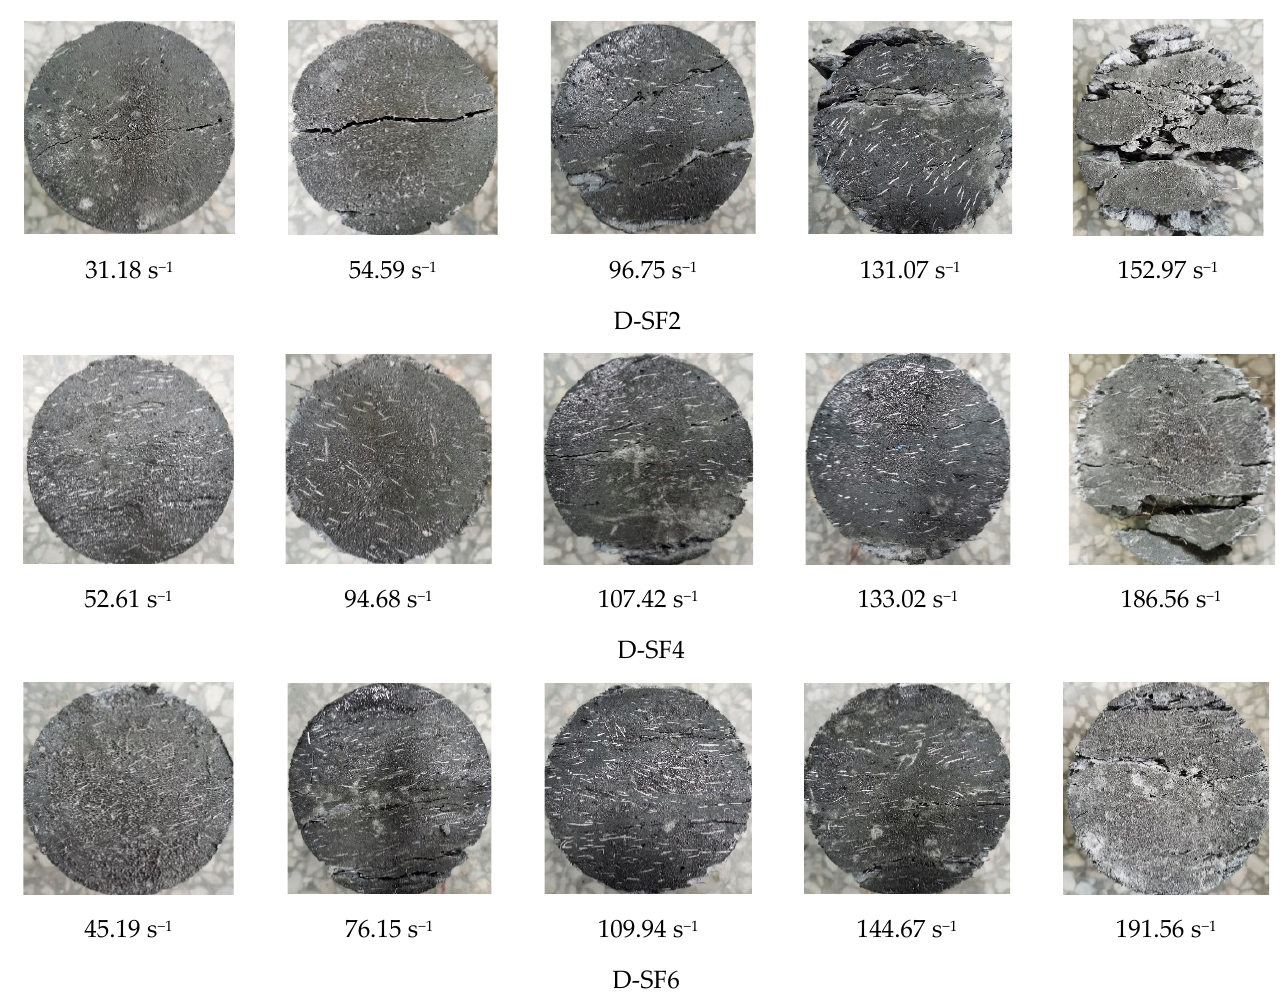
Figure 10. Failure pattern of fiber-oriented UHPC impact compression test.